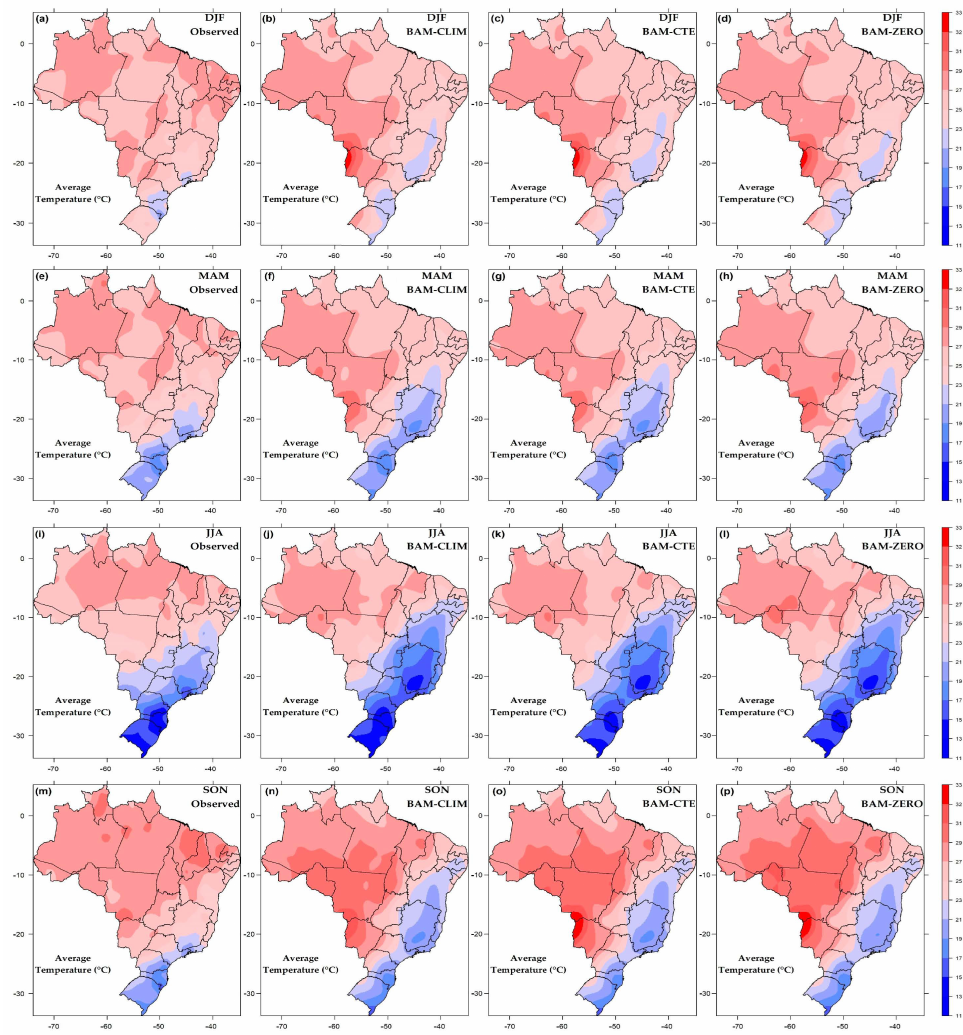
Figure 4. Seasonal averages of mean temperature ( ◦ C). In the upper panel, values obtained for summer (DJF) from observations ( a ), BAM-CLIM ( b ), BAM-CTE ( c ), and BAM-ZERO ( d ). In the second panel, the same for autumn (MAM) from observations ( e ), BAM-CLIM ( f ), BAM-CTE ( g ), and BAM-ZERO ( h ). In the third panel, the same for winter (JJA) from observations ( i ), BAM-CLIM ( j ), BAM-CTE ( k ), and BAM-ZERO ( l ). In the last panel, the same for spring (SON) from observations ( m ), BAM-CLIM ( n ), BAM-CTE ( o ), and BAM-ZERO ( p